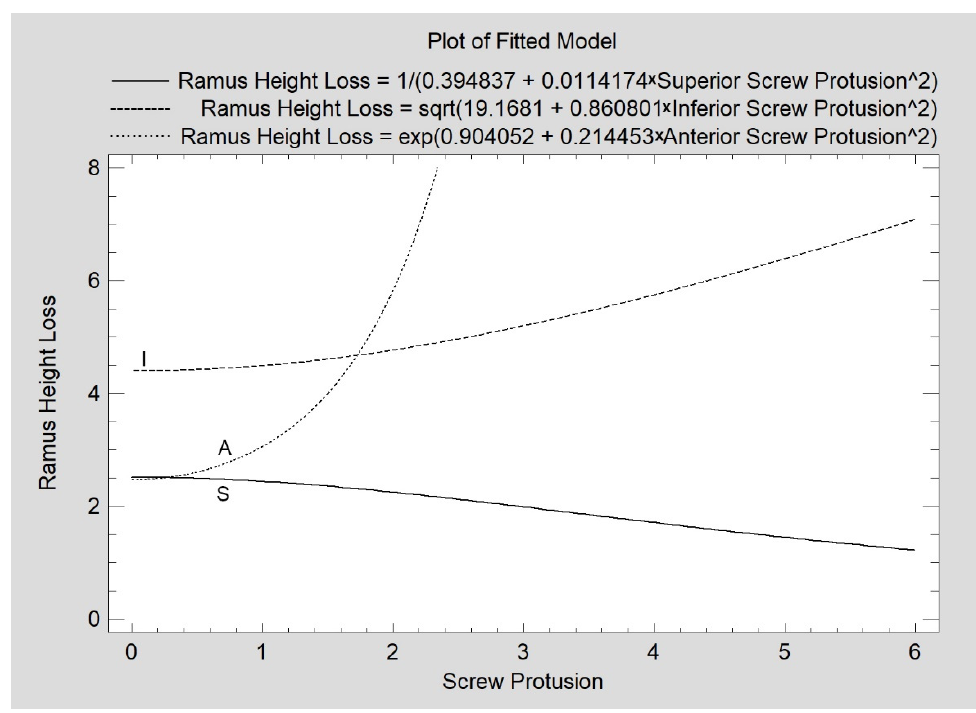
Figure 8. Influence of screw protrusion at the time of surgery on the fate of maintaining the height of the mandibular ramus. The values of protrusion for each screw location are statistically signifi- cantly related to the changes in the ramus height ( p < 0.05). S—superior screw; I—inferior screw; A—anterior screw. Table 2. Evaluation of bone union quality after twelve months of healing and